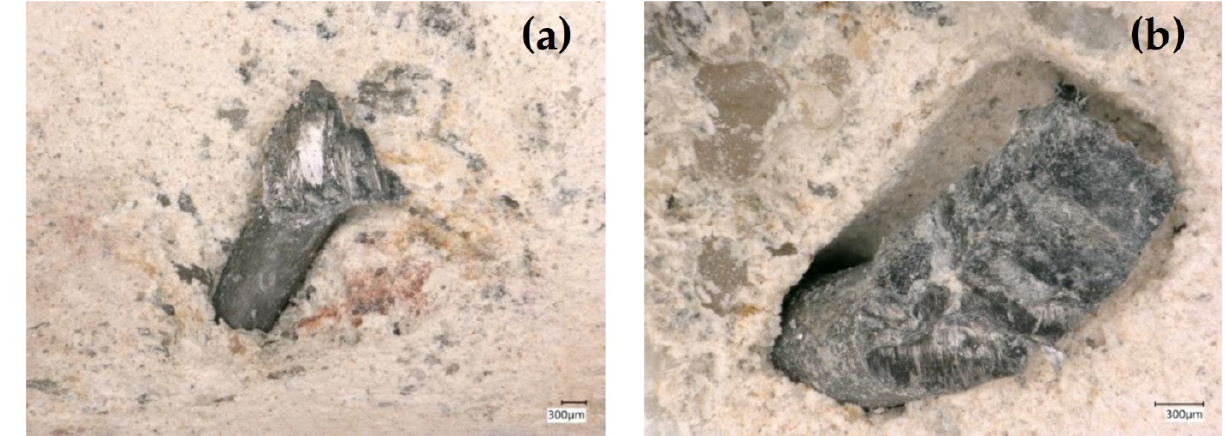
Figure 2. Cross-section deformation ( a , b ), local spalling ( b ), and rupture ( a , b ) of exposed steel fibres in boreholes.